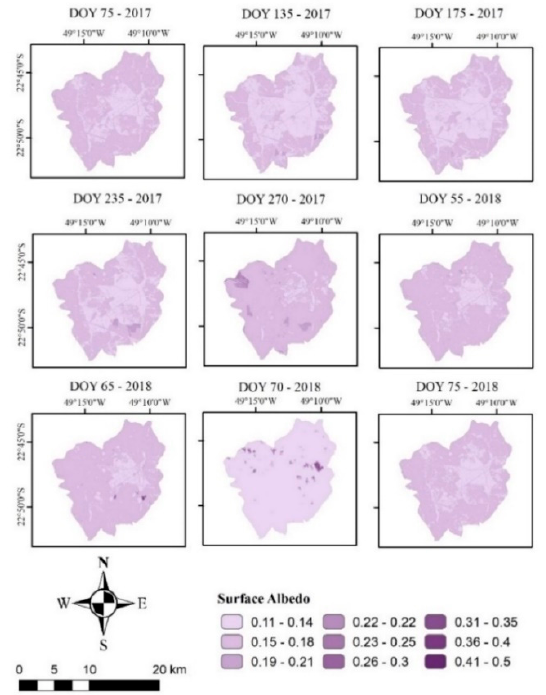
Figure 5. Surface albedo at a daily scale between 2017 and 2018 in watersheds with varied land use (DOY = day of year).